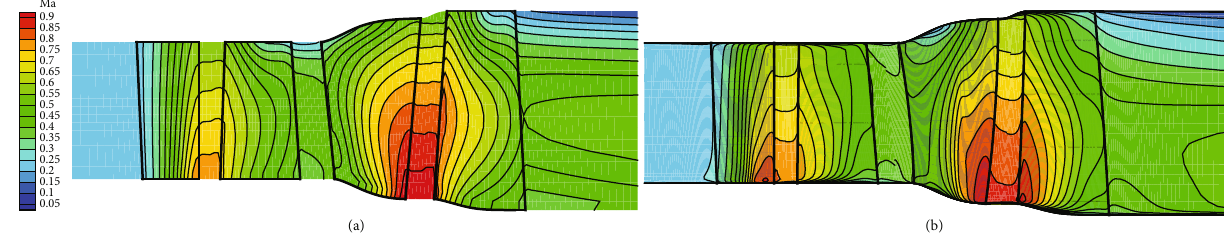
Figure 8: Absolute Mach number of the two-stage turbine: (a) Q3D; (b) 3D.